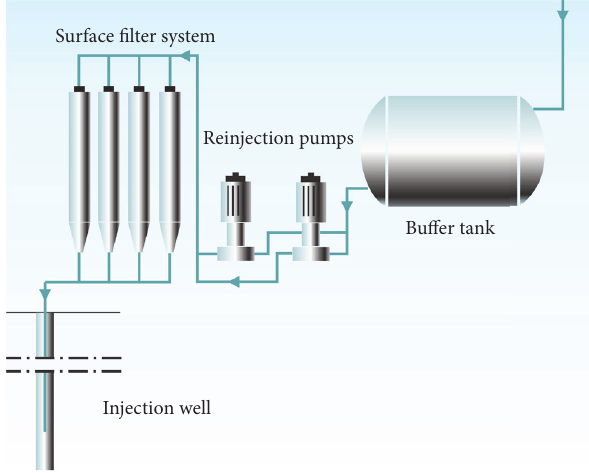
the replacement of filters was after 2500–5000 m 3 fluid flowed through. Figure 4: The main parts of the thermal water reinjecting system (modified from